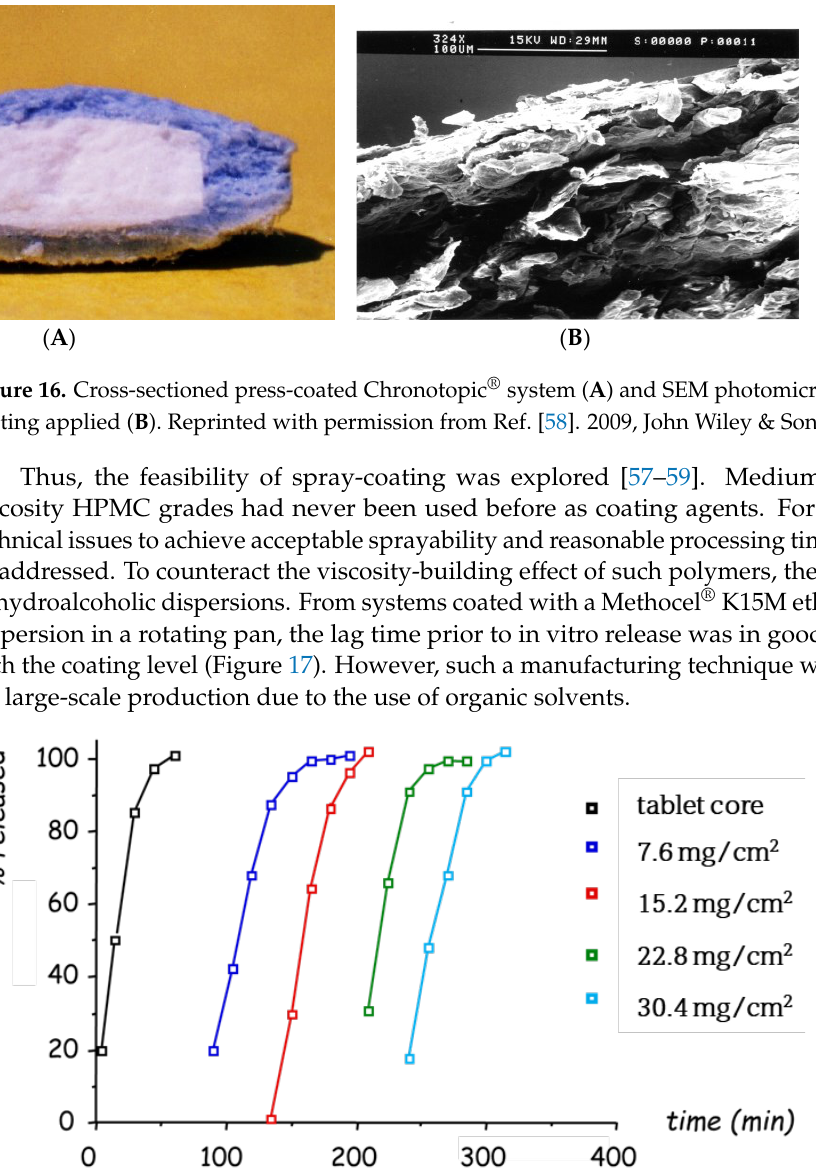
Figure 17. Release profiles of indomethacin from uncoated tablets (4 mm diameter) and systems spray-coated with Methocel ® K15M to increasing coating levels. Adapted with permission from Ref. [58]. 2009, John Wiley & Sons.